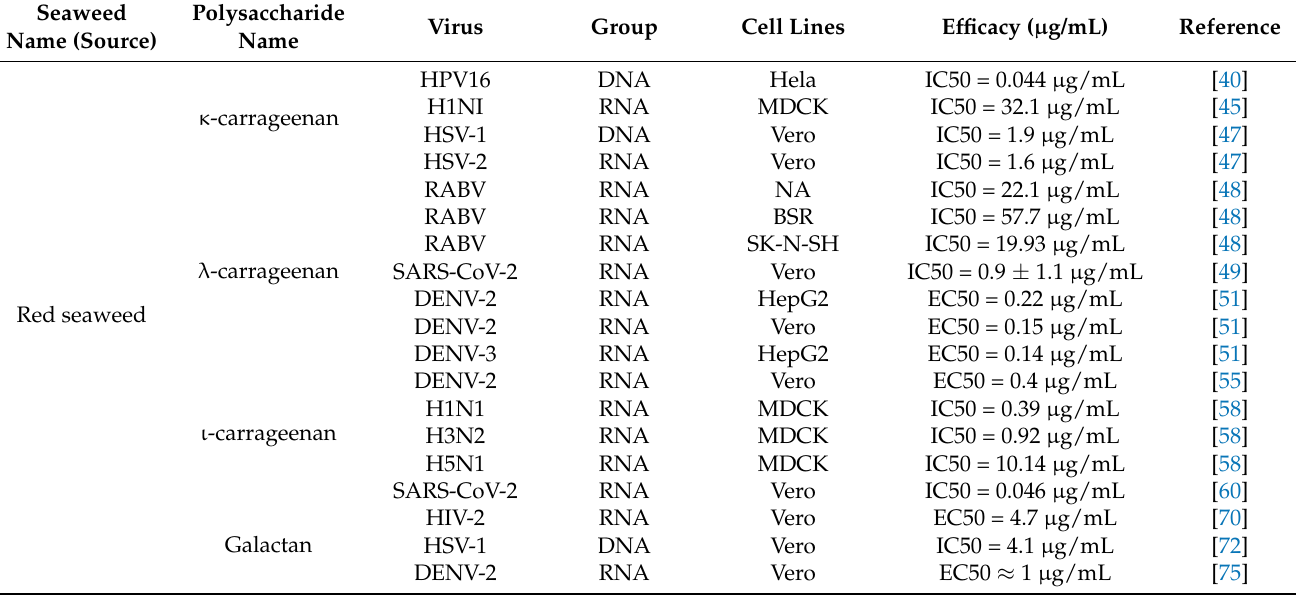
Table 1. Advances in research on the antiviral activity of sulfated polysaccharides from